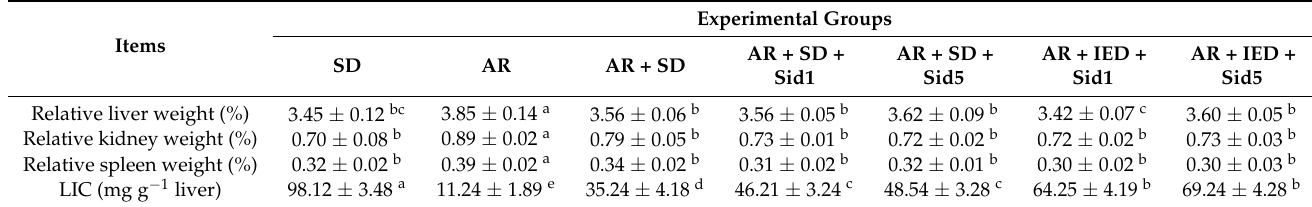
Table 3. The relative weight of liver, kidneys, and spleen and iron concentration in the liver of rats fed different formulated experimental diets with an intraperitoneal injection of Sid after a recovery period of 4 weeks ( n =